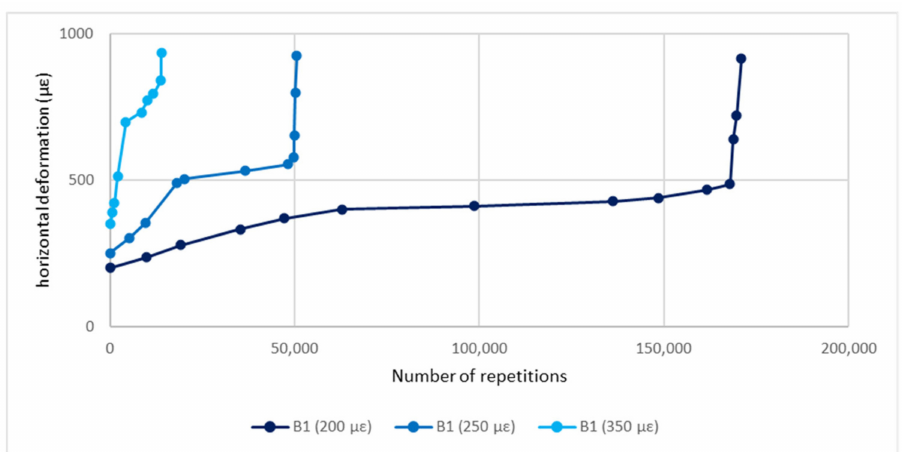
Figure 11. Deformation curves of B1 for different initial strain values.